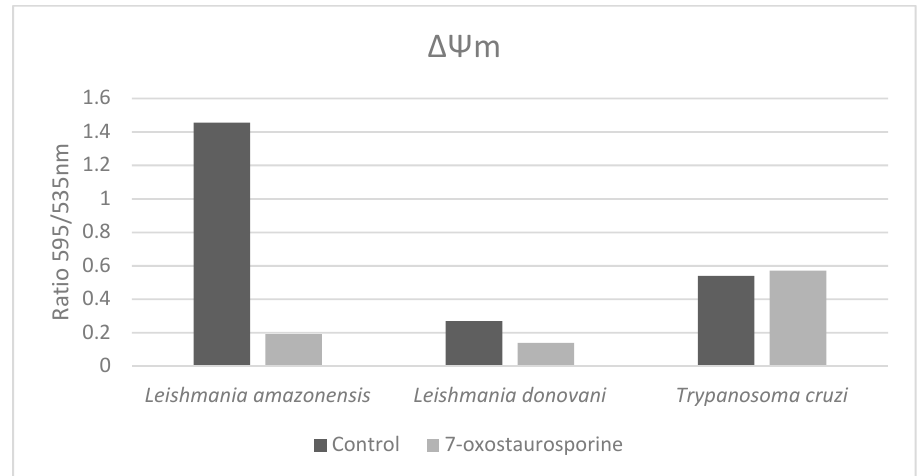
Figure 2. Changes in the mitochondrial membrane potential of Leishmania spp. promastigotes and T. cruzi epimastigotes after treatment at the IC 90 of 7OSTS ( 2 ) for 24 h. Control corresponds to untreated parasites.